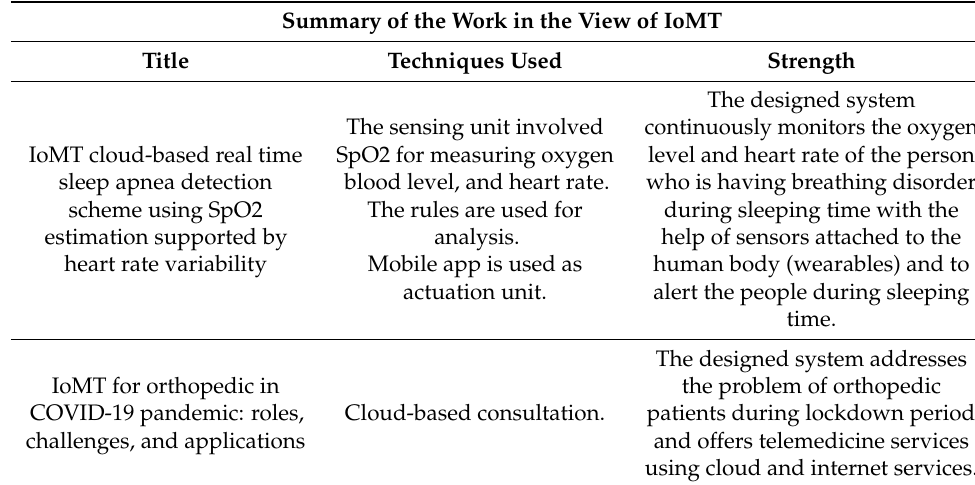
Figure 1. Overview of Internet of Medical Things. Table 1. Summary of the work in the view of IoMT.